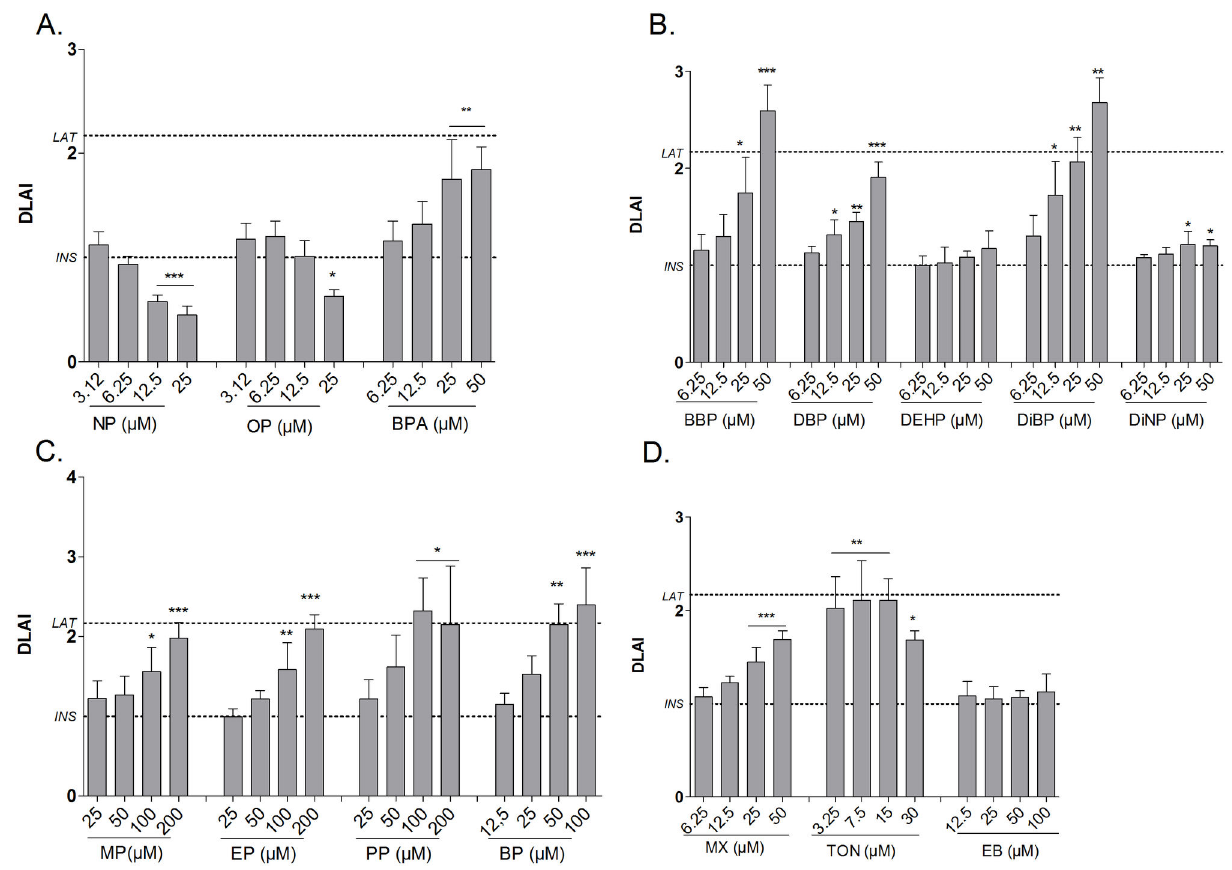
Figure 7. Effect of combined insulin and test compound exposure on adipocyte differentiation in 3T3-L1 cells after 10 days of